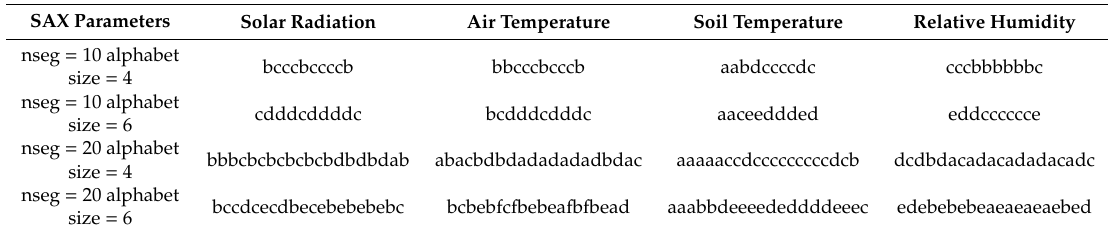
Table 2. Resulting Symbolic Aggregate Approximation (SAX) strings on consensus data.